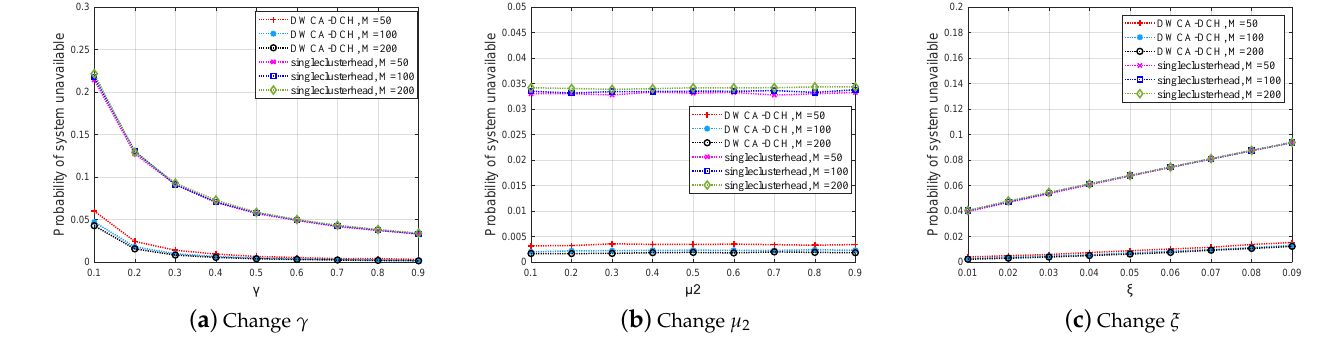
Figure 9. The variation trend of system unavailable probability with different parameters. Figure 10 shows the trend of system available probability of the proposed DWCA- DCH over time, and compares it with MLSC algorithm [14] and the single cluster head algorithm. It can be seen that as time goes on, in the proposed DWCA-DCH, the available probability of the system gradually declines and then rebounds, maintaining a stable trend on the whole. This is because as time goes on, the remaining energy of the p/bCH gradually decreases, and the movement of the UAVs causes the change of distance between